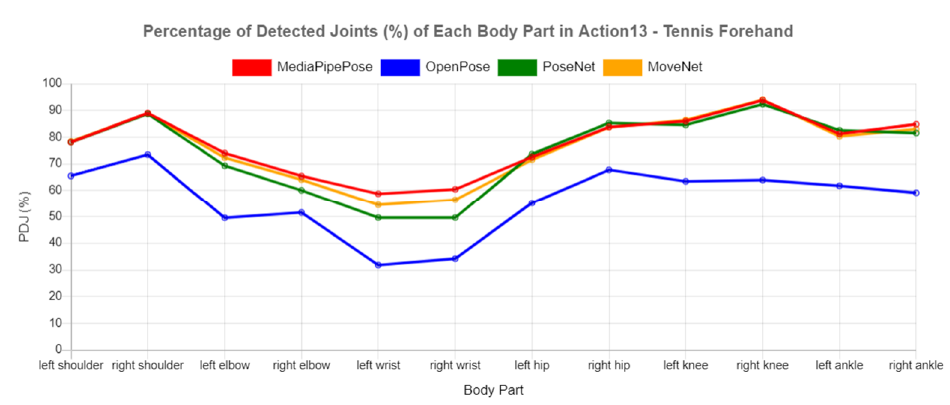
Figure 11. PDJ for each body part in Action 13–tennis forehand.